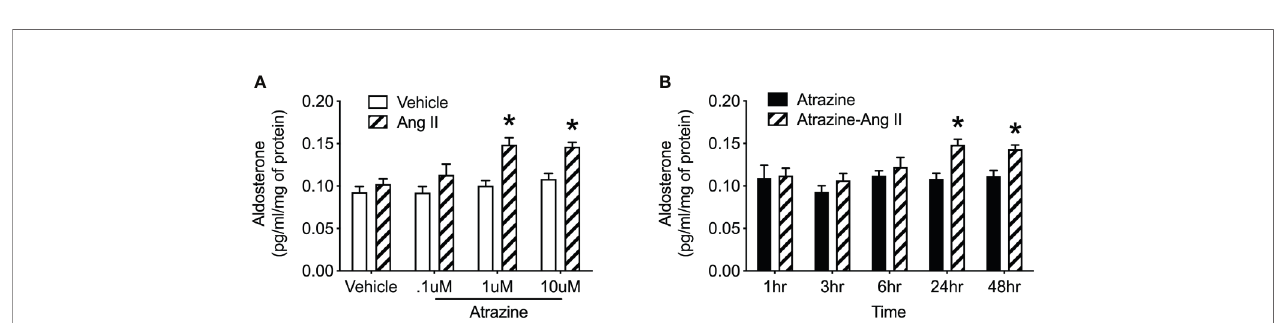
FIGURE 4 | Atrazine increases Ang II-induced aldosterone synthesis in human adrenal cell lines. (A) Histogram depicting mean media concentration of aldosterone (pg/ml/mg) in cell cultures treated with atrazine (.1, 1.0, or 10.0 µm) or atrazine plus Ang II (0.1 nM). Atrazine treatment was 24 h in duration. (B) Histogram depicting mean media concentration of aldosterone (pg/ml/mg) in media of H295R cell cultures treated with atrazine (1 µm; solid black bars) or atrazine plus Ang II (0.1 nM). Atrazine treatment was 1, 3, 6, 24, or 48 h in duration. Data presented as the mean ± SEM. Asterisk signi fi es difference from control group ( P <